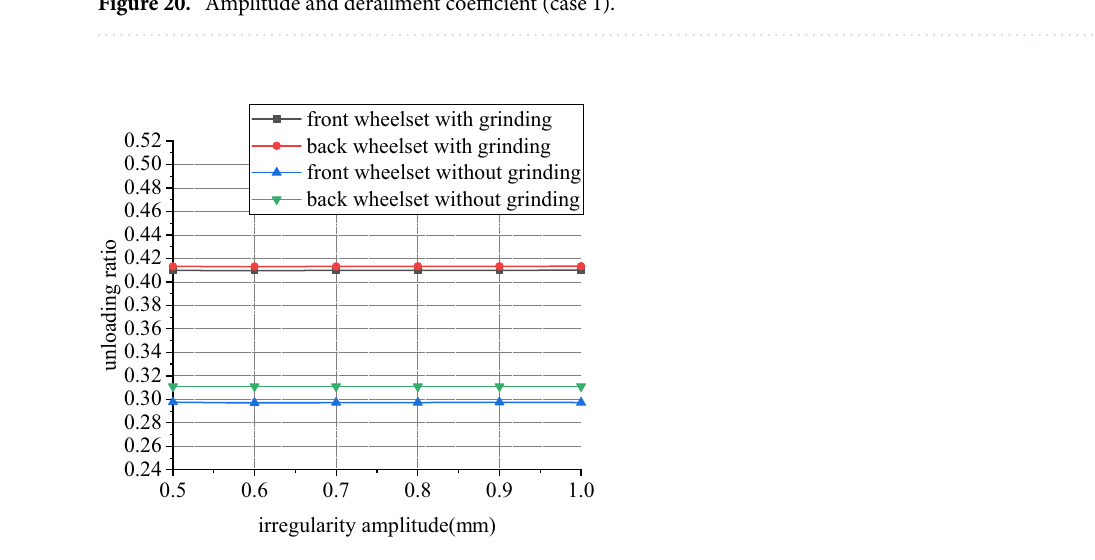
Figure 21. Amplitude and unloading ratio (case 1).